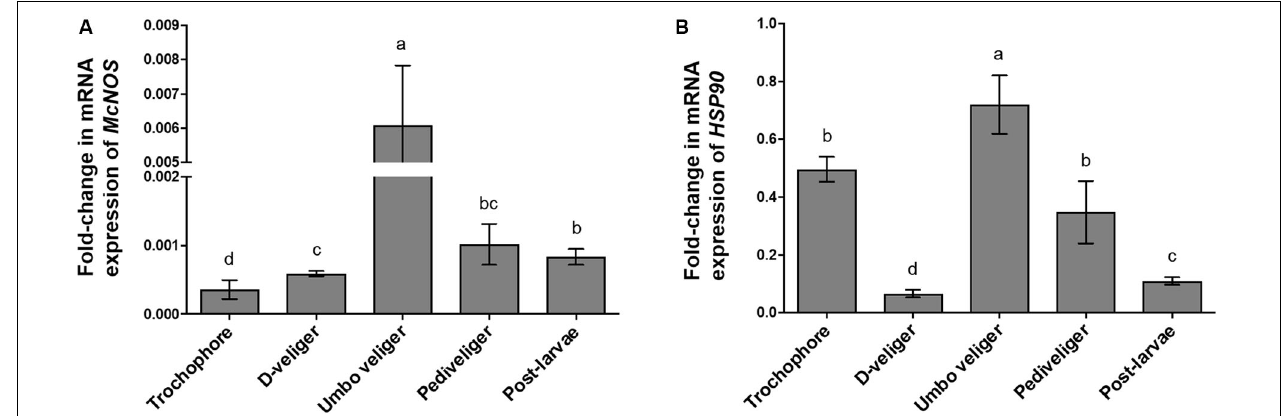
FIGURE 6 | Temporal expression of NOS mRNA during M. coruscus ontogenesis. (A) mRNA expression levels of McNOS in different developmental stages. (B) mRNA expression levels of HSP90 in different developmental stages. The EF-1 α gene was used as an internal control to normalize the relative mRNA levels of McNOS and HSP90 . Results are means ± SEM ( n = 6), and bars with different letters are significantly different ( p < 0.05).